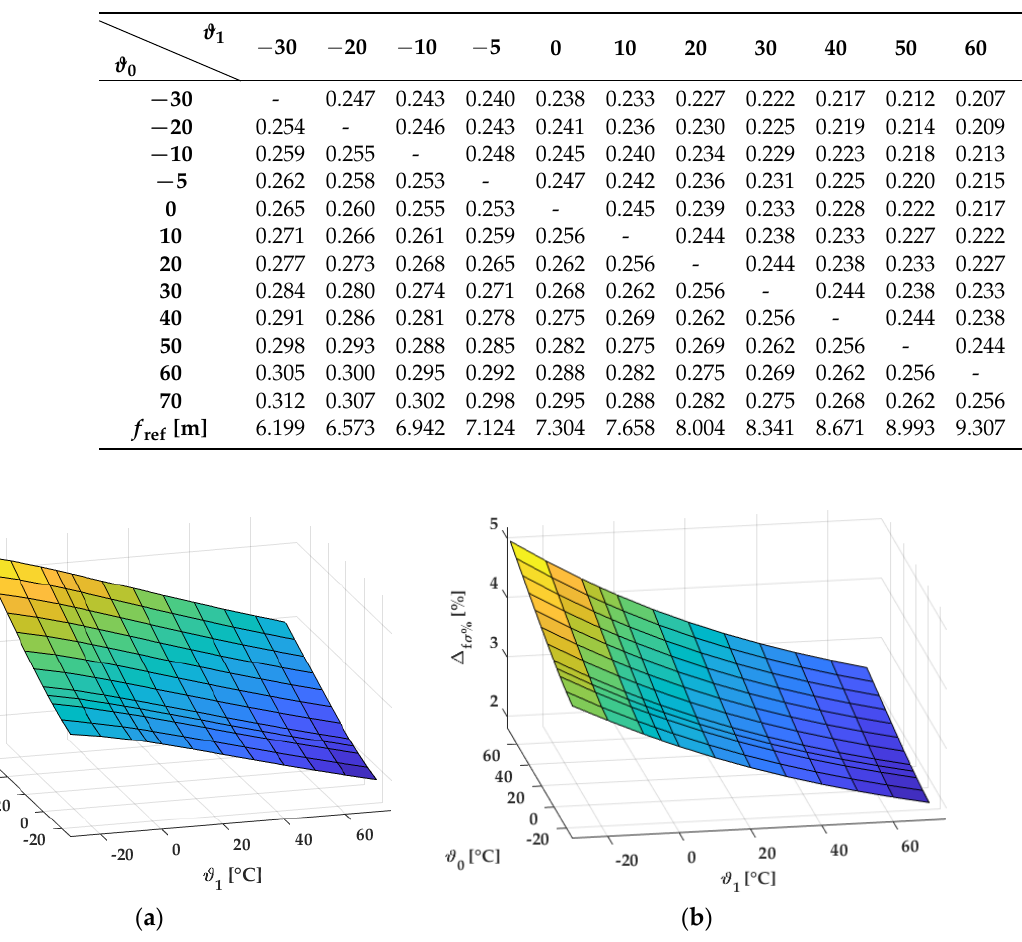
Table 5. Maximum absolute sag deviations Δ fσ [m] caused by the incorrect determination of the conductor initial mechan- ical tension.